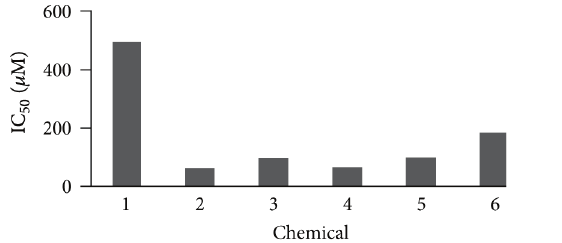
F 4: Inhibitory effects of the six pentacyclic triterpene com- pounds 1–6 isolated from H. tyermanni Moore LPS-induced NO production in RAW264.7 macrophages ( assayed by Griess